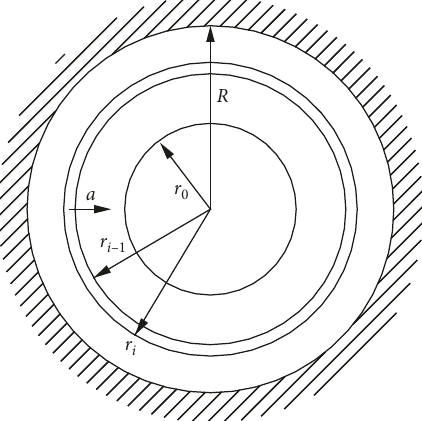
Figure 9: Conversion of the concentrated load S ∗ along the transverse direction of a tunnel.